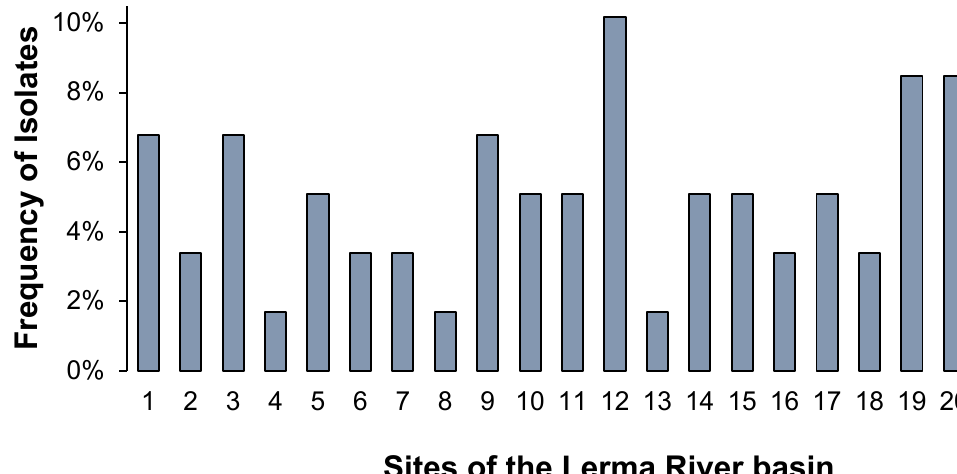
Figure 1. Frequency (%) of ß-lactam-resistant-Gram-negative bacteria isolated from the Lerma River basin according to the sampling location (1 through